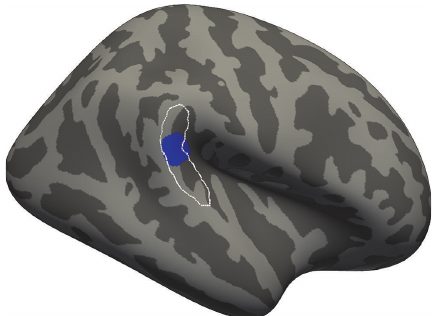
Figure 2: Visual motion detection thresholds in the right PTR predict cortical thickness (blue region). The region of the effect was first identified in the right PTR ROI (white outline) according to our a priori hypothesis and then expanded to include all vertices at 𝑝 < 0.01 , in order to explore its location when unbounded by the ROI.